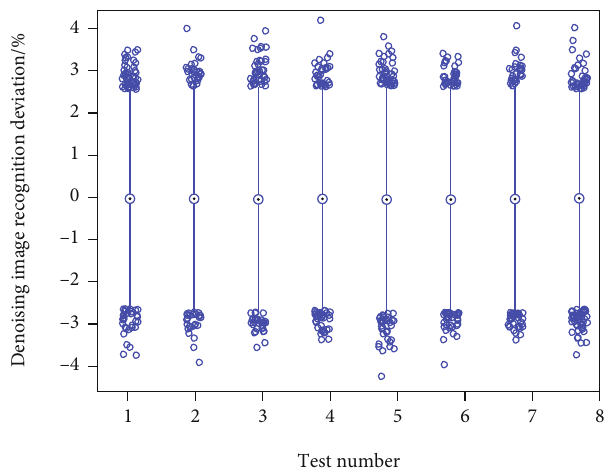
Figure 8: Box diagram of denoising image recognition degree deviation.